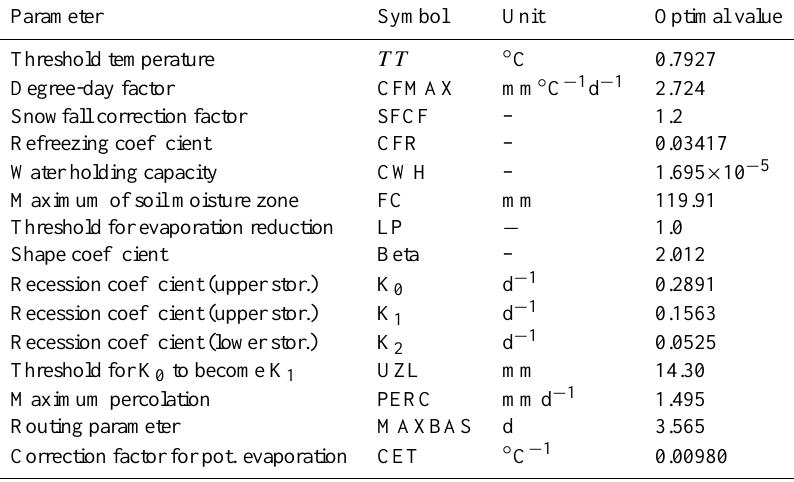
Table 2. Parameters of the HBV model and their optimal values resulting from calibration and validation.